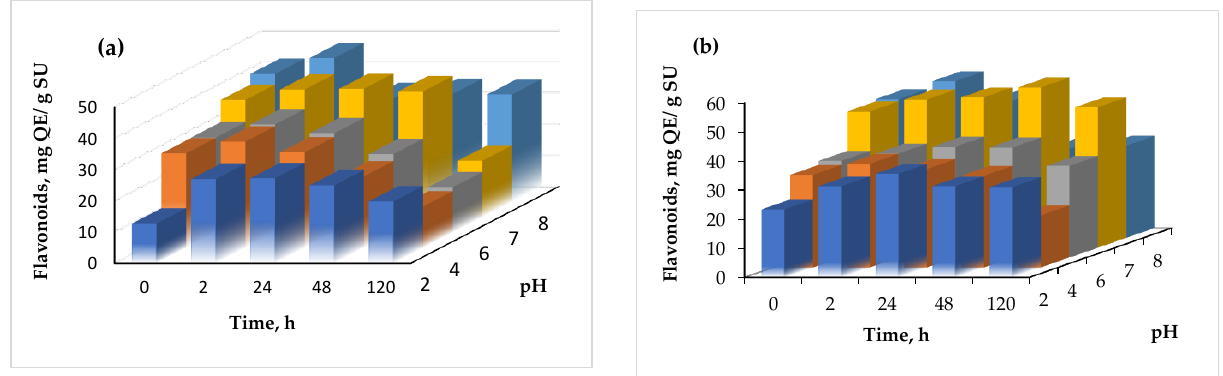
Figure 6. The effect of pH on the flavonoid content of the powders ( a ) variant 1, ( b ) variant (2). The pH stability was checked at a constant value for variable periods, ranging from 0 to 120 h. From Figure 6, it can be seen that in general, the flavonoid content increased with time, up to 24 h, and started to slowly decrease at a more prolonged time with every test, regardless of the variant. The highest increase of the flavonoid content was found at pH 2.0, after 2 h, when a two-fold increase of the flavonoid content was found in variant 1.